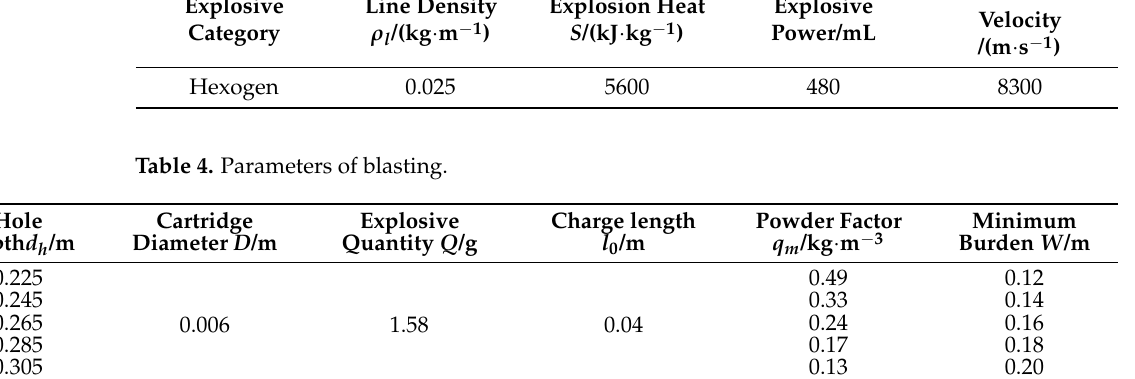
Table 2. Physical and mechanical parameters of materials.